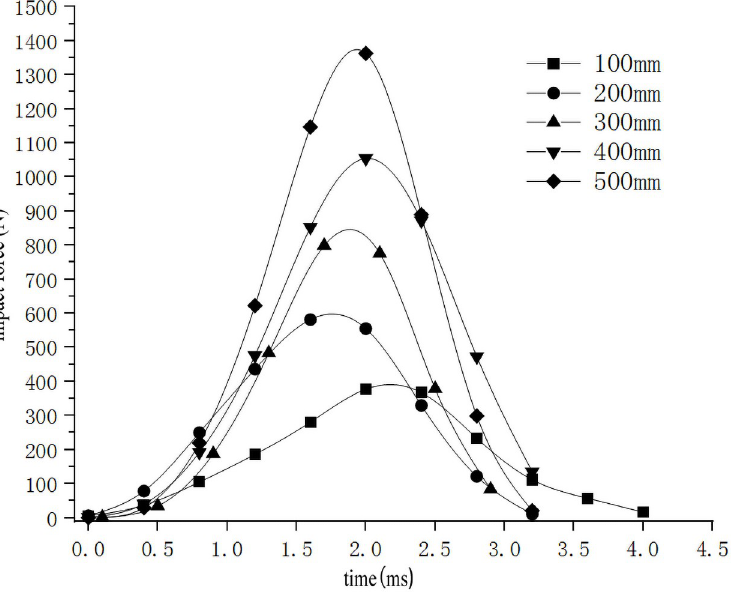
Fig 5. Impact force-time relationship during drop impact at different